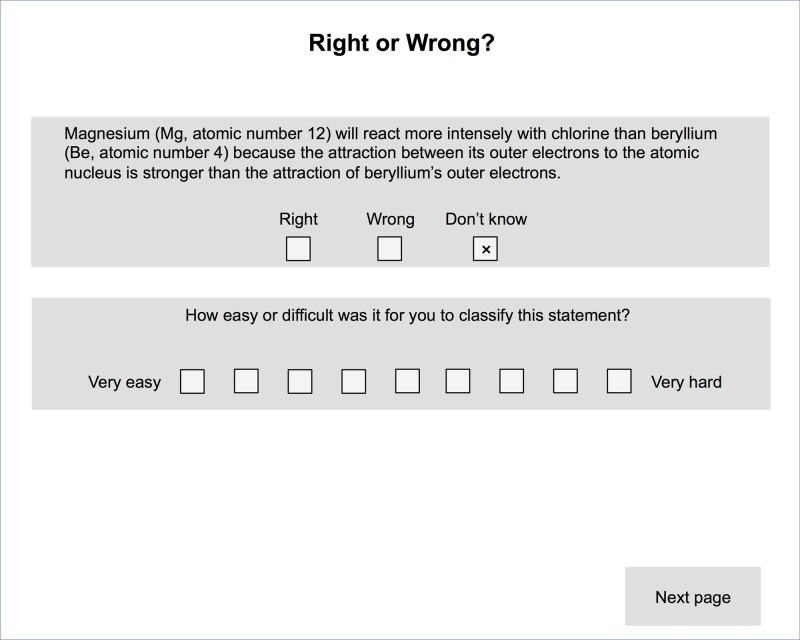
Screenshot of a rapid verification task (translated from German).